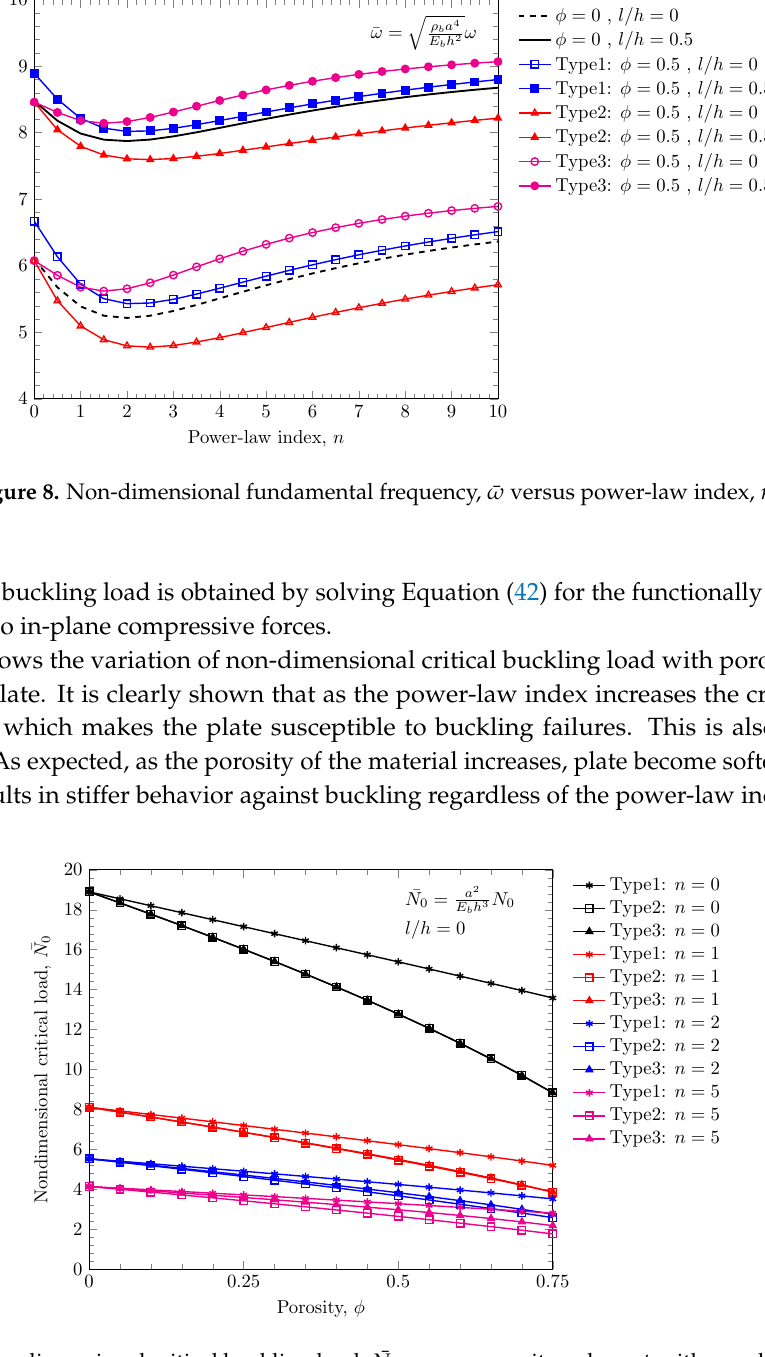
Figure 9. Non-dimensional critical buckling load, ¯ N 0 versus porosity values, φ with zero length scale parameter l / h =